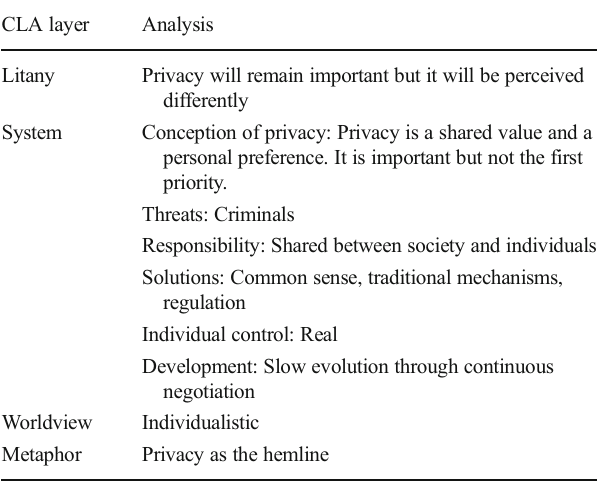
Table 4 Causal layered analysis of privacy as the hemline ( n = 5) CLA layer Analysis Litany